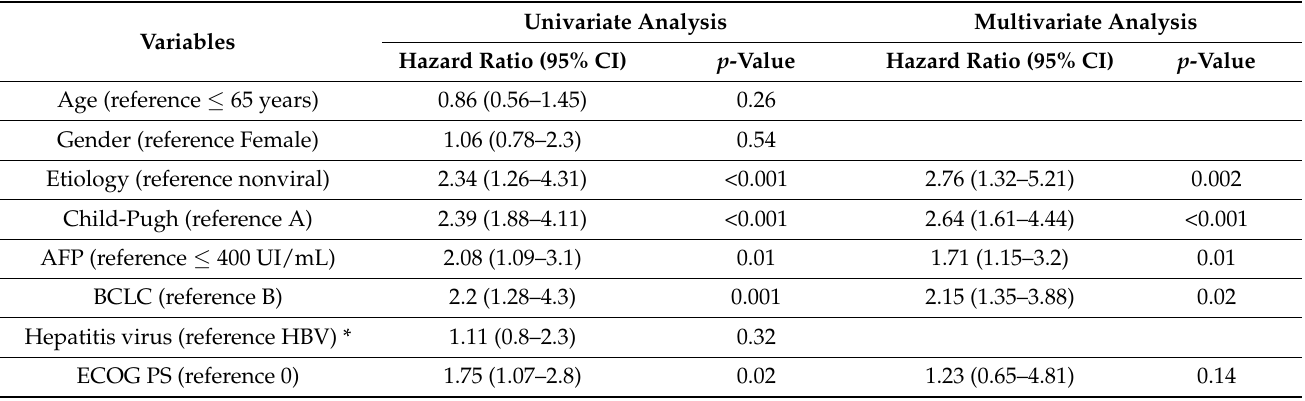
Table 2. Cox univariate/multivariate regression for overall